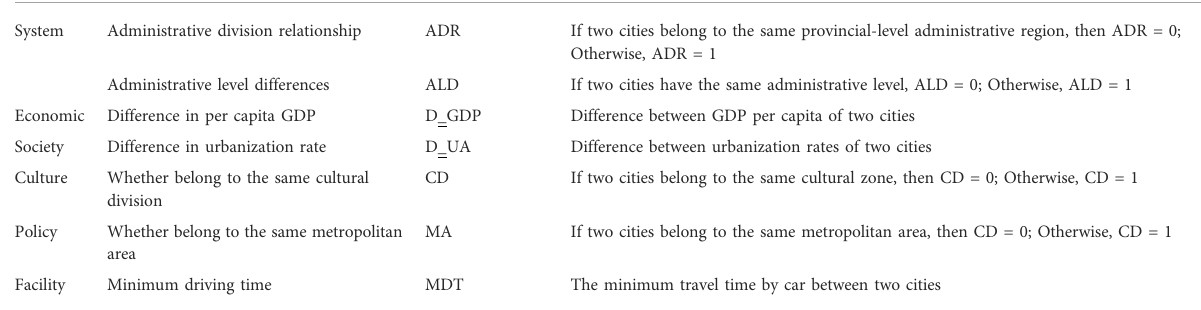
TABLE 3 De fi nition of explanatory